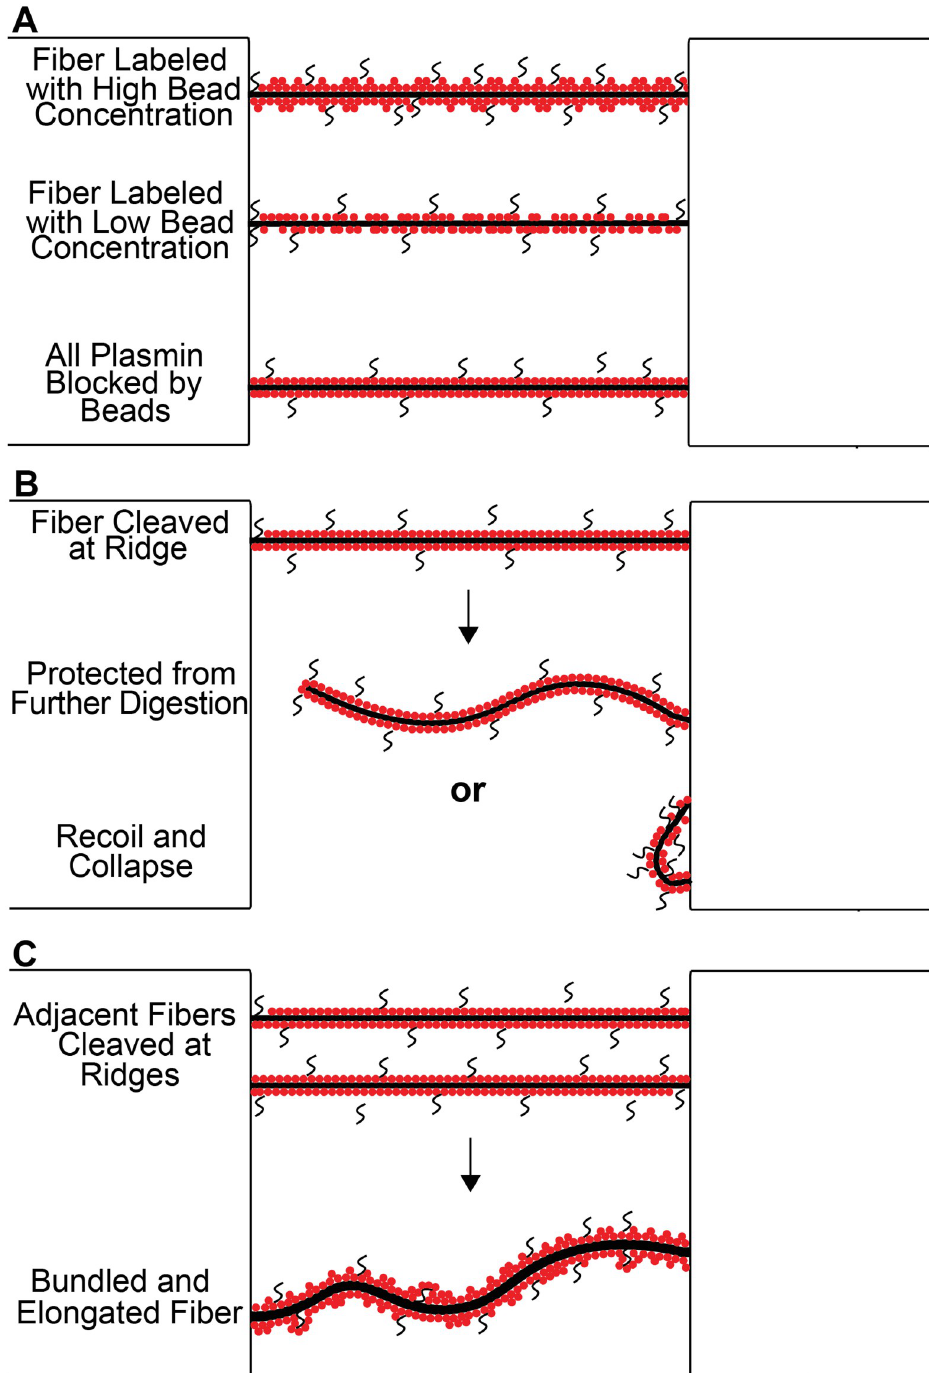
Fig 8. Cartoon Model: (A) The proposed sheathing mechanism and the disparity between cleavage location at differing bead dilutions are shown for three representative fibers, denoted as black lines. Fluorescent beads are shown as red circles and plasmin is represented as a black s-shape. The uppermost fiber is indicative of plasmin binding locations being dispersed evenly across a fiber when high fluorescent bead concentrations are utilized. The middle fiber represents the preferential ridge cleavage of fibers labeled with lower bead concentration, as the beads fill the length of the fiber, blocking most plasmin binding sites rather than the ridge locations. The bottom fiber represents a scenario where a fiber remains uncleaved and tensed due to the fluorescent beads completely blocking all plasmin binding. (B) The potential digestive outcomes of a ridge-cleaved fiber are shown. The uppermost fiber is cleaved